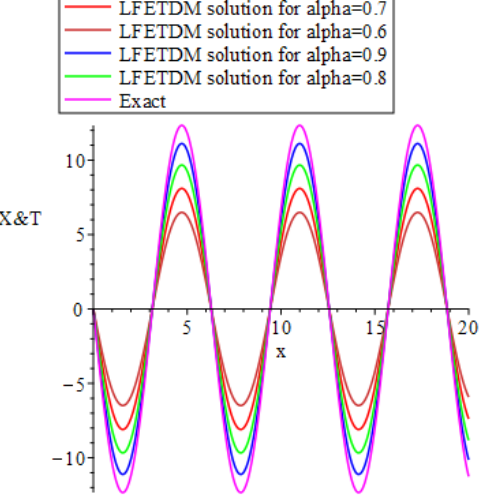
Figure 2. A comparison of the LFETDM solutions for alpha = 0.9, alpha = 0.8, alpha = 0.7 , alpha = 0.6 and the exact solution of the system (38).